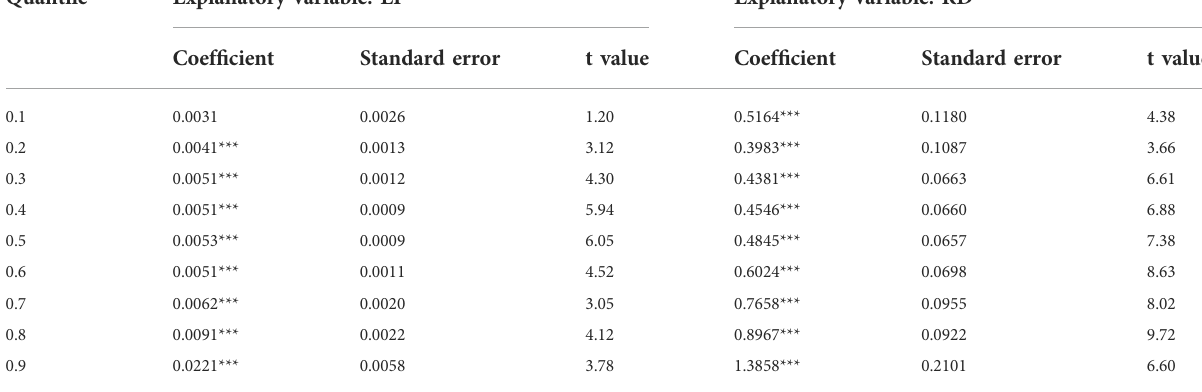
TABLE 5 Results of quantile regression.